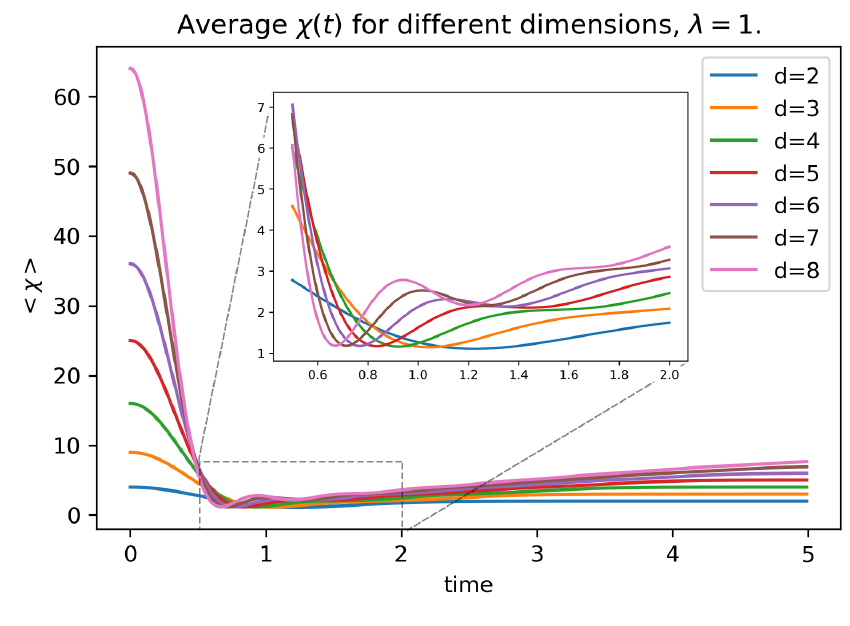
Figure 4: 〈 χ ( t ) 〉 , for d ∈ { 2,3,...8 } . λ = 1, the variance of the GUE